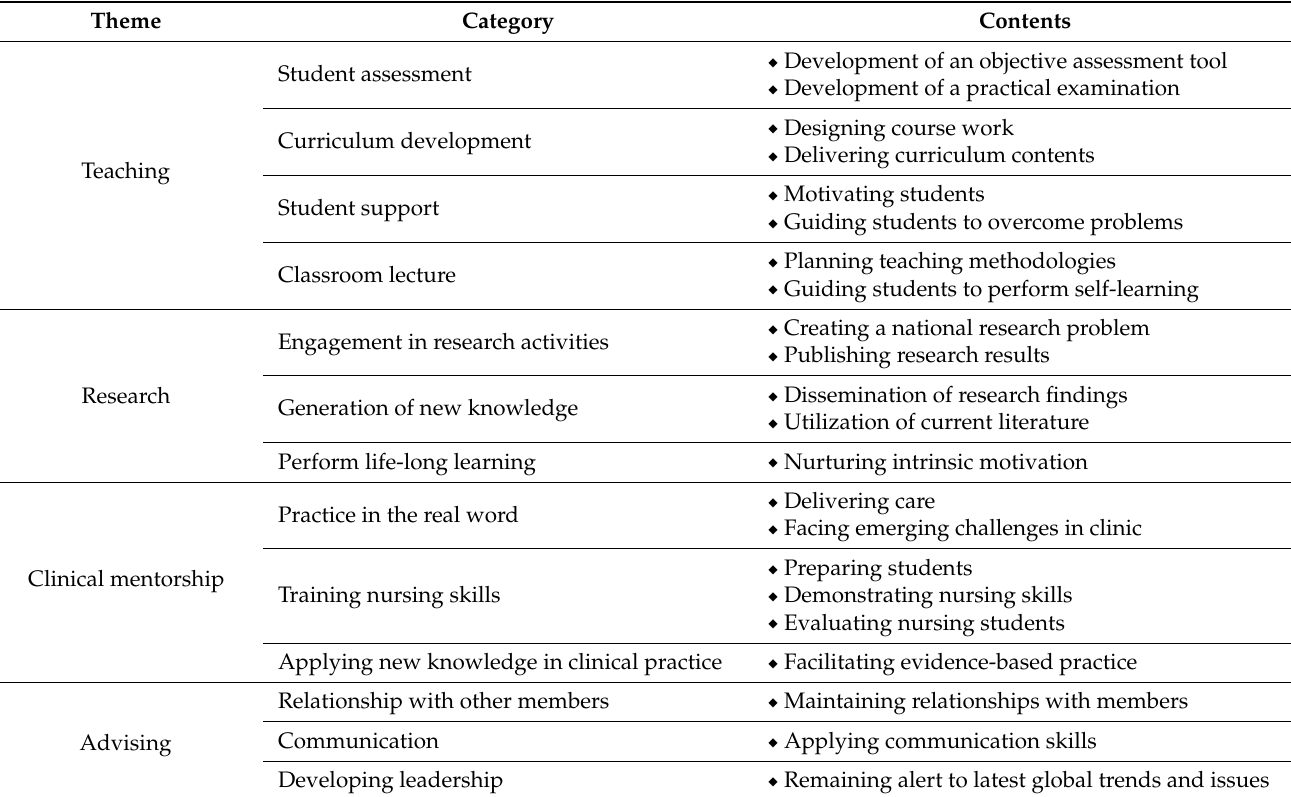
Table 1. Four themes extracted from concept analysis.